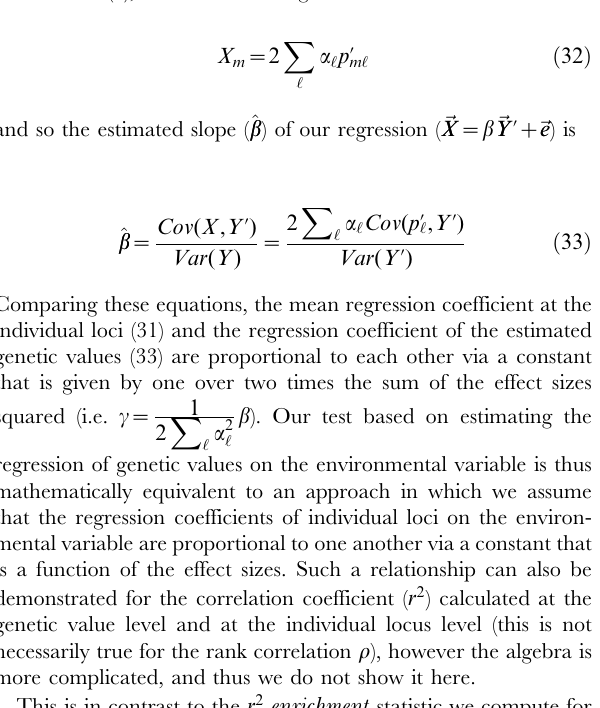
Figure S1 Power of tests described in the main text to detect a signal of selection on the mapped genetic basis of skin pigmentation [67] as an increasing function of the strength of selection (A), and a decreasing function of the genetic correlation between skin pigmentation and the selected trait with the effect of selection held constant at d ~ 0 : 13 (B). Figure S2 Power of tests described in the main text to detect a signal of selection on the mapped genetic basis of BMI [74] as an increasing function of the strength of selection (A), and a decreasing function of the genetic correlation between BMI and the selected trait with the effect of selection held constant at d ~ 0 : 07